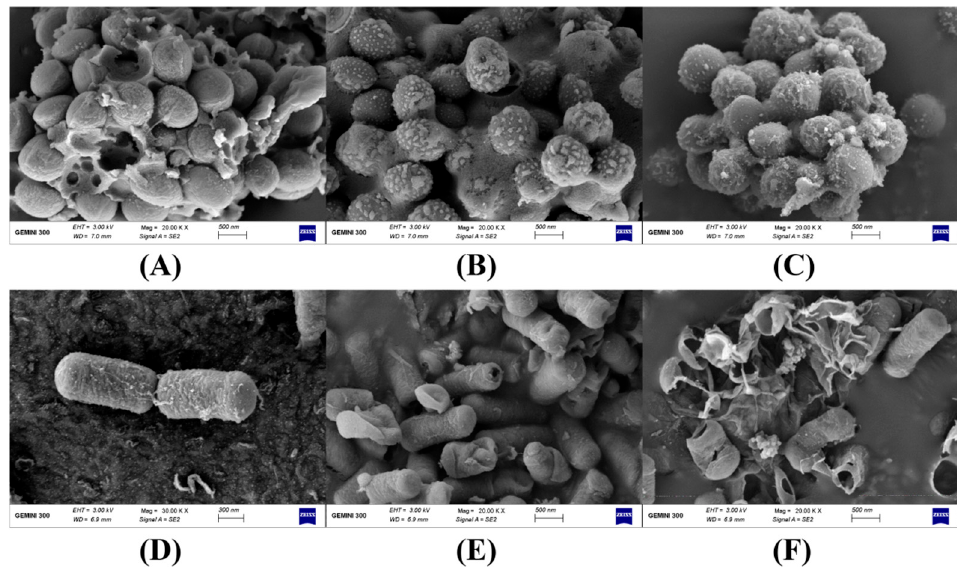
Figure 3. SEM images of Staphylococcus aureus and Bacillus subtilis exposed to different treatments. ( A ) Untreated Staphylococcus aureus . ( B ) Staphylococcus aureus treated by ε -PL. ( C ) Staphylococcus aureus treated by whey protein- ε -PL complexes. ( D ) Untreated Bacillus subtilis . ( E ) Bacillus subtilis treated by ε -PL. ( F ) Bacillus subtilis treated by whey protein- ε -PL complexes. The concentration of ε -PL was 5000 μ g/mL and the mass ratio of whey protein-to- ε -PL was 1:1.